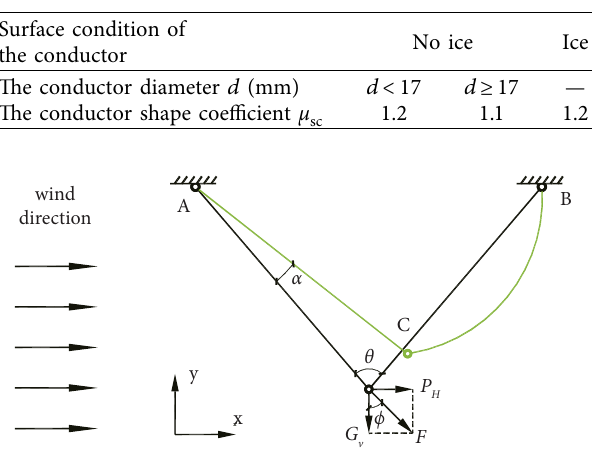
Table 2: Te shape coefcient values of conductors with diferent diameters.